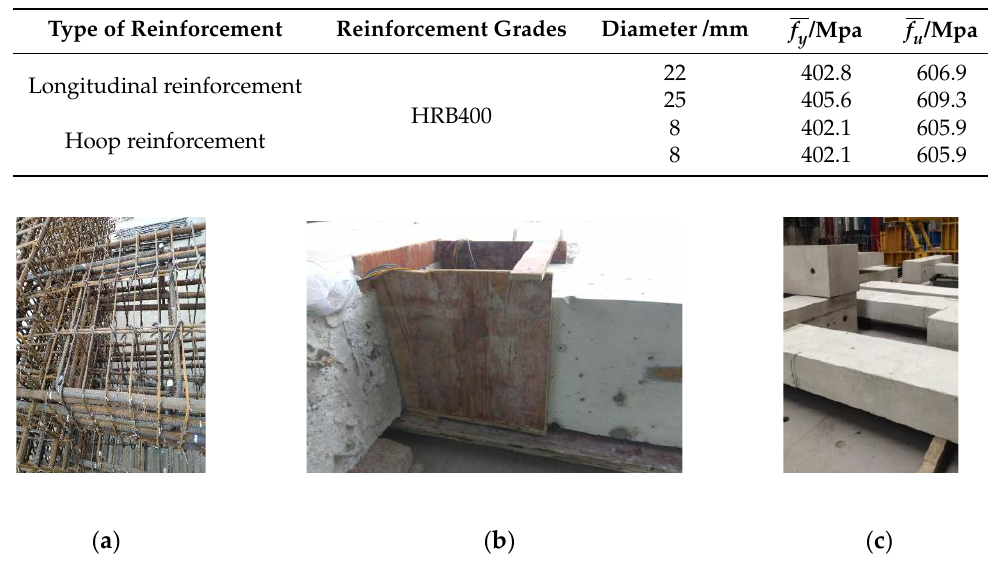
Figure 6. Fabrication and completion of the test piece: ( a ) Tying of reinforcement cage; ( b ) Second casting; ( c ) Completion of casting